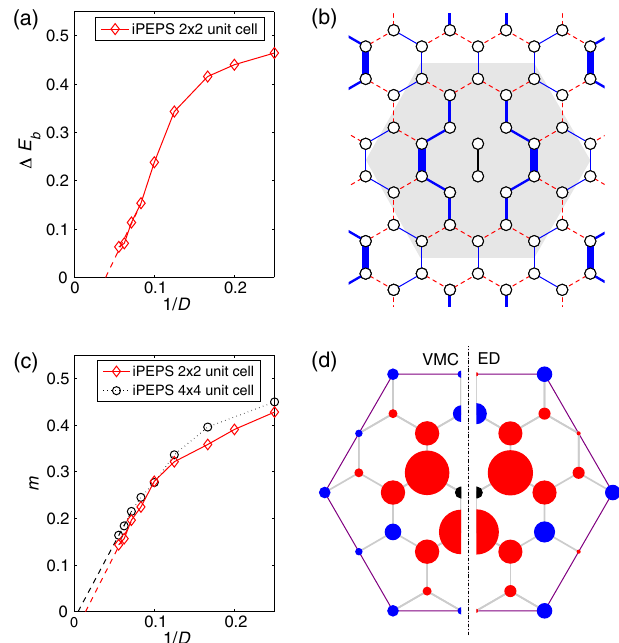
FIG. 4. Various correlation functions obtained with iPEPS, ED, and VMC methods. (a) Difference in bond energies obtained with iPEPS in the state shown in Fig. 3(d). The difference is strongly suppressed with increasing bond dimension D and vanishes in the infinite- D limit. (b) Connected bond-energy correlations h P ij P kl i (cid:3) h P ij ih P kl i calculated with ED in the ground state of the N ¼ 24 sample. The black bonds denote the reference bond. Solid blue (dashed red) bonds stand for positive (negative) correlation functions, and the width of the bond is proportional to the absolute value of the correlation function. (c) Local ordered moment m obtained with iPEPS as a function of inverse bond dimension. The moment vanishes in the infinite- D limit for both low-energy states shown in Figs. 3(c) and 3(d). (d) Spin-correlation function in real space, as calcu- lated from ED (right) and VMC (left) for a 24-site cluster. The area is proportional to h P 0 i i (cid:3) 1 = 4 , where 0 is the index of the central site, and i labels the sites in the 24-site cluster. The color keeps track of the sign (blue for positive, red for